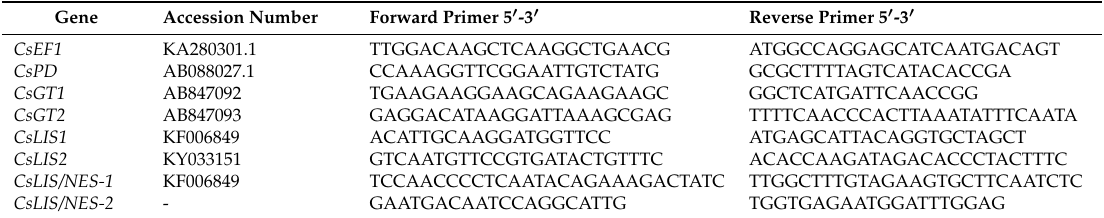
Table 1. The primers used for quantitative real time PCR (qRT-PCR) in the